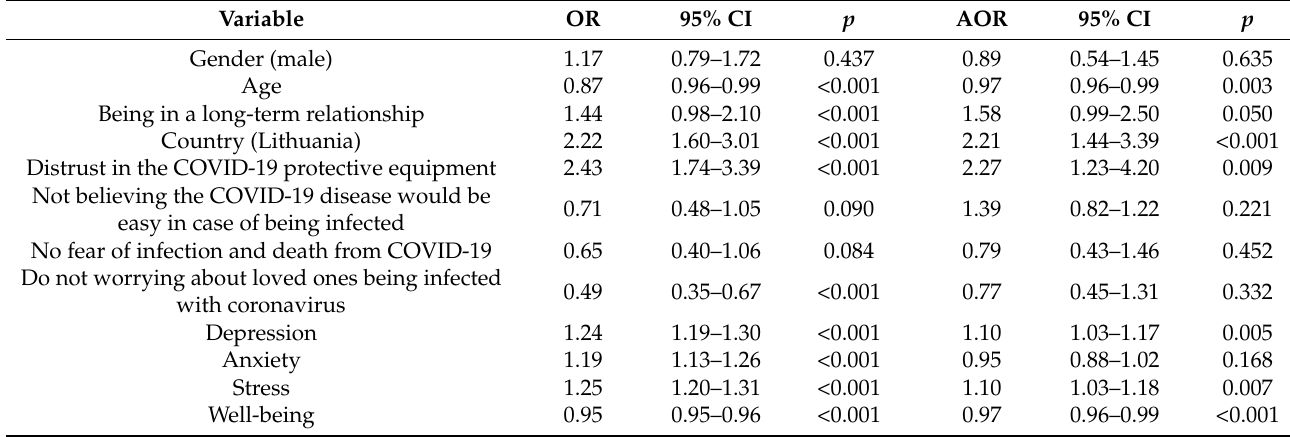
Table 2. Predictors of career change ideation and working outside the healthcare area in healthcare professionals ( N =